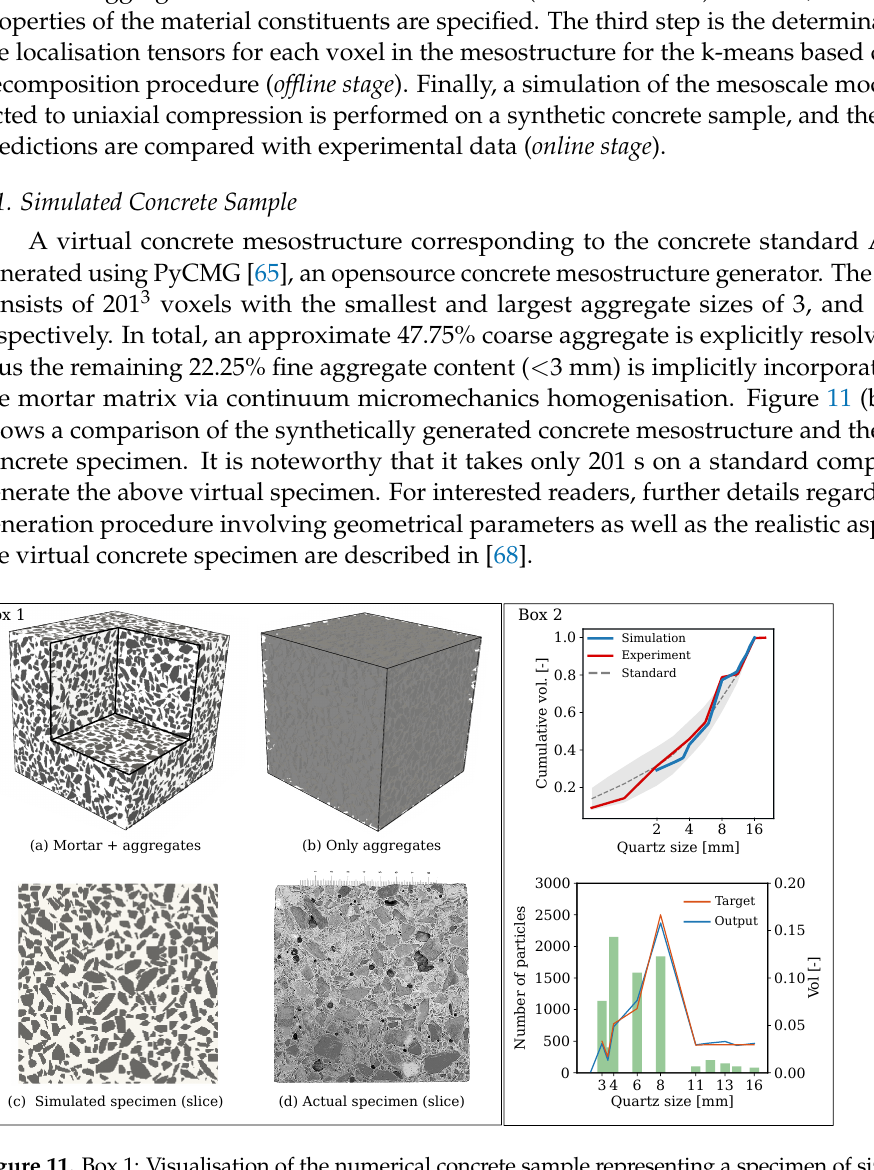
Figure 11. Box 1: Visualisation of the numerical concrete sample representing a specimen of size 10 cm (top), and qualitative comparison between slices of virtual and actual samples (bottom), Box 2: Cumula- tive volume distribution of aggregates (top) and size distribution of the quartzitic particles